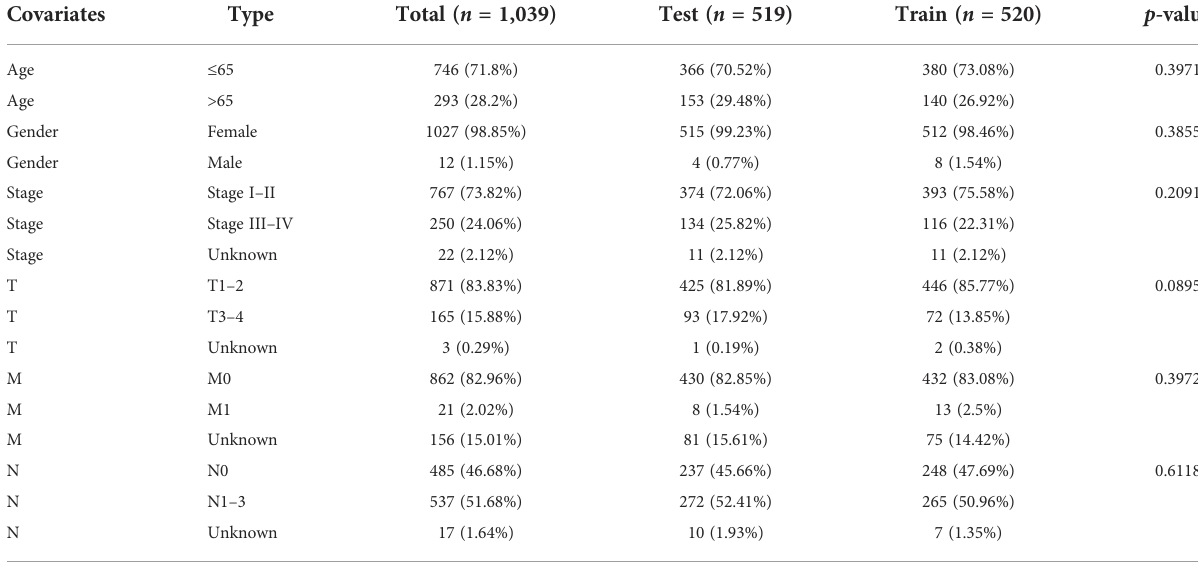
TABLE 1 The correlation between the two groups in demographic and clinical characteristics for breast cancer patients.